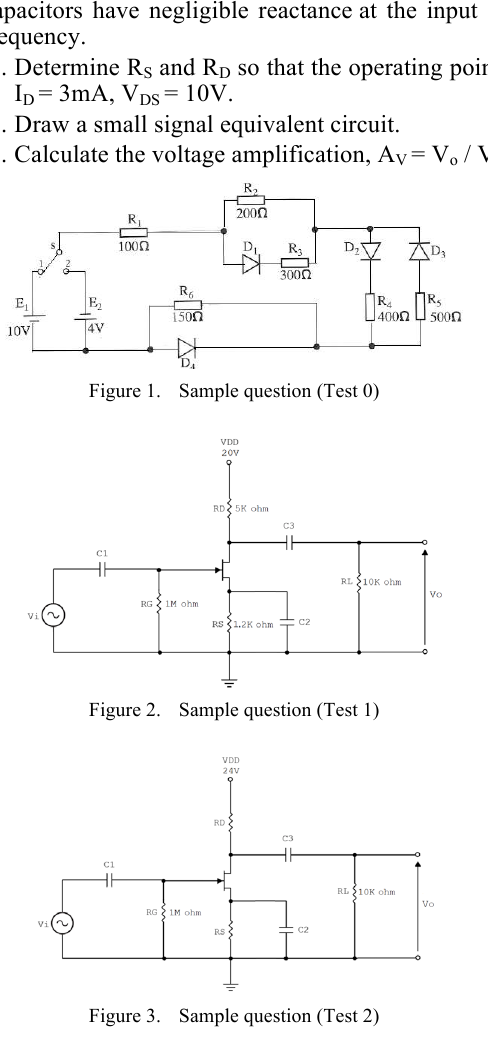
Figure 3. Sample question (Test